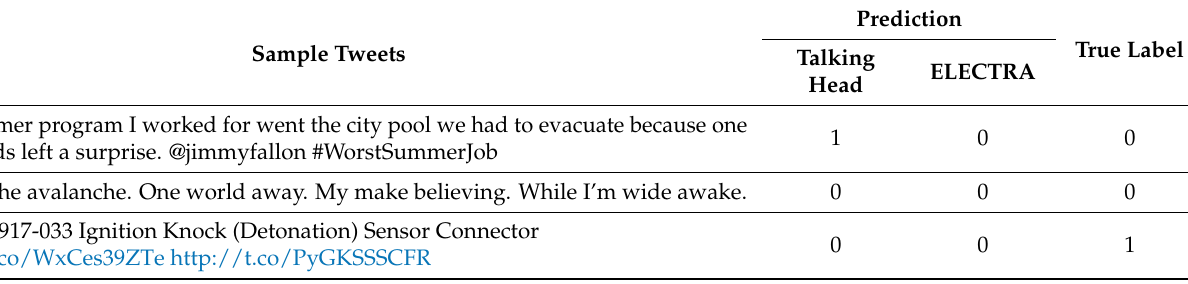
Table 6. Sample detection results for